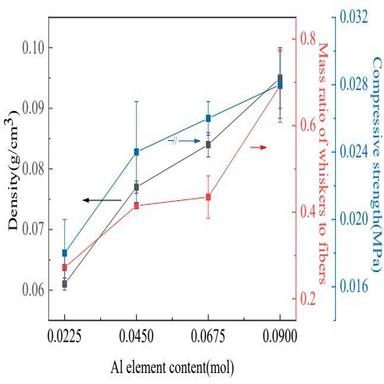
Density, whisker/fiber mass ratio, and compressive strength of MFWs with different precursor concentration.